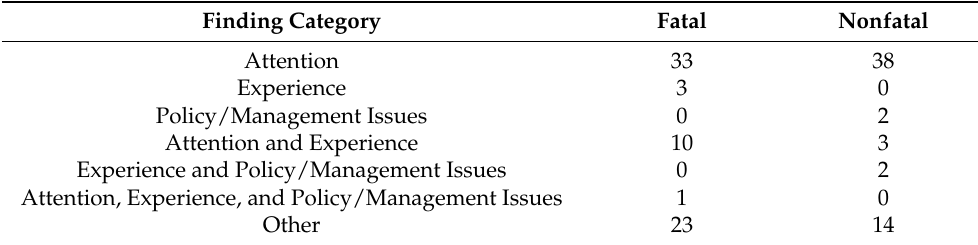
Table 1. Additional findings identified by the NTSB